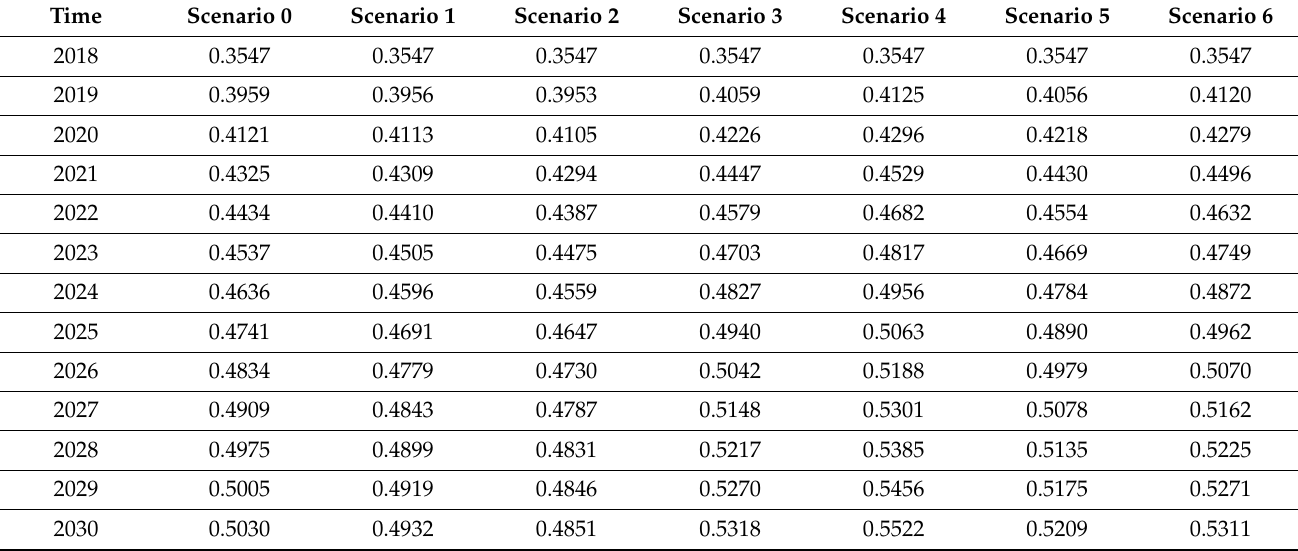
Table 6. Competitiveness index of the cement